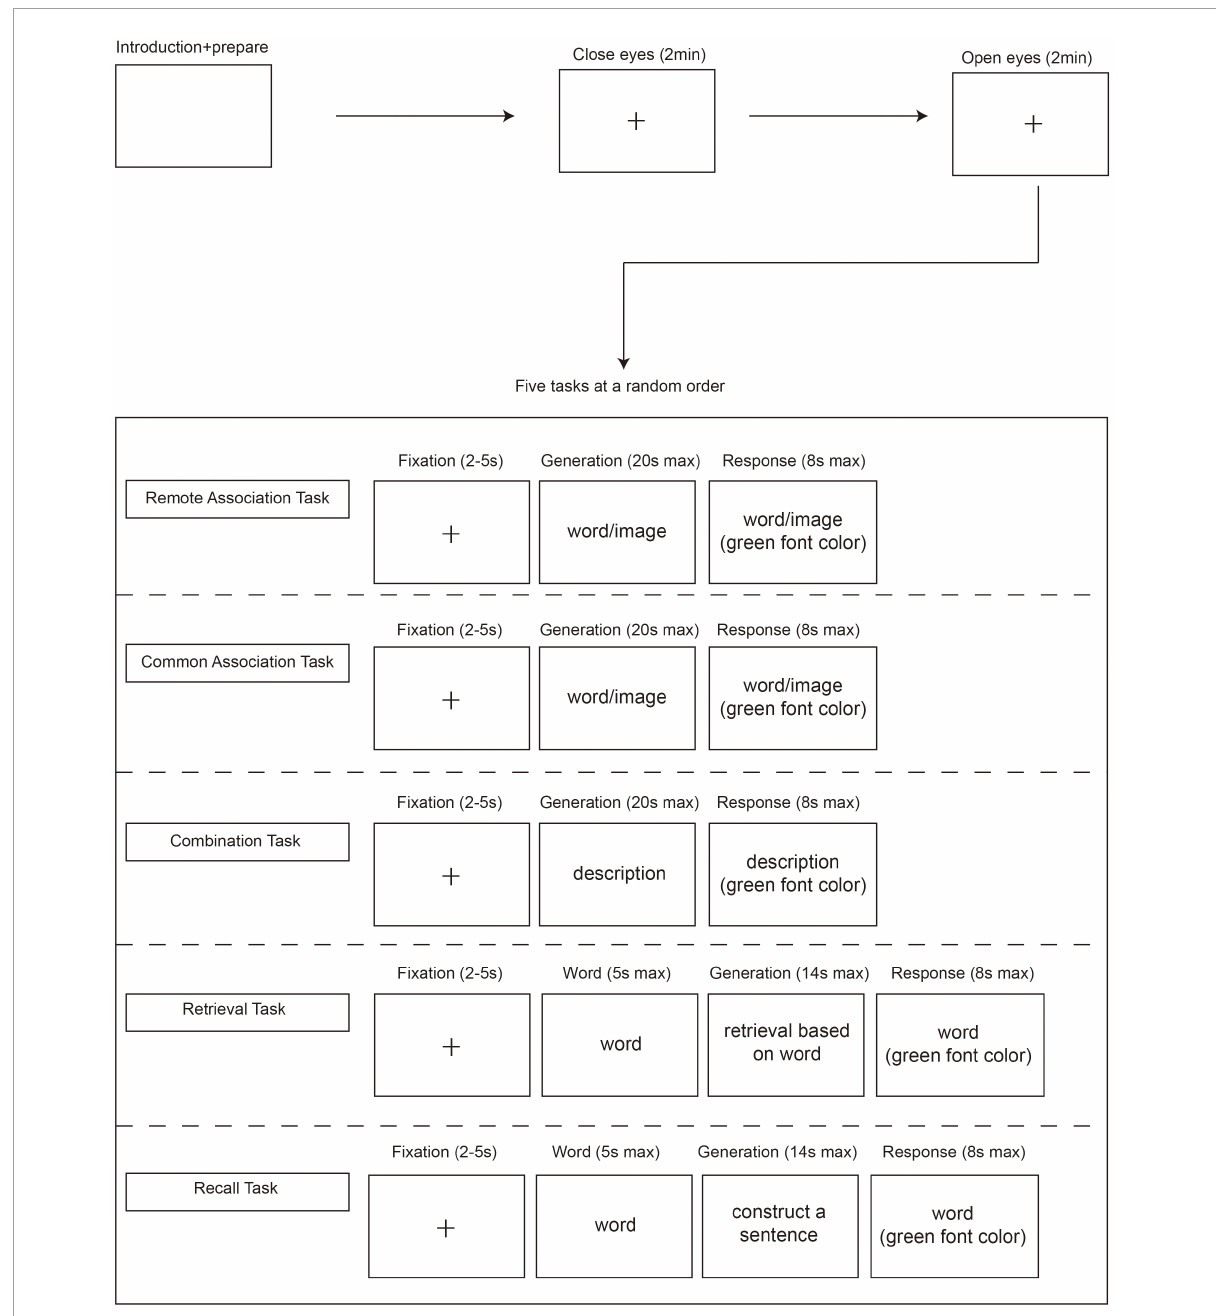
FIGURE1 Study procedure. After introducing the tasks, the electroencephalography (EEG) devices were worn. Participants first opened or closed their eyes for 2 min. Then, the five cognitive-factor induction tasks (each one tailored to remote association, common association, retrieval, combination, and recall) were conducted in random order. The entire study lasted around 1 h. Participants can have a 5-min rest after each induction